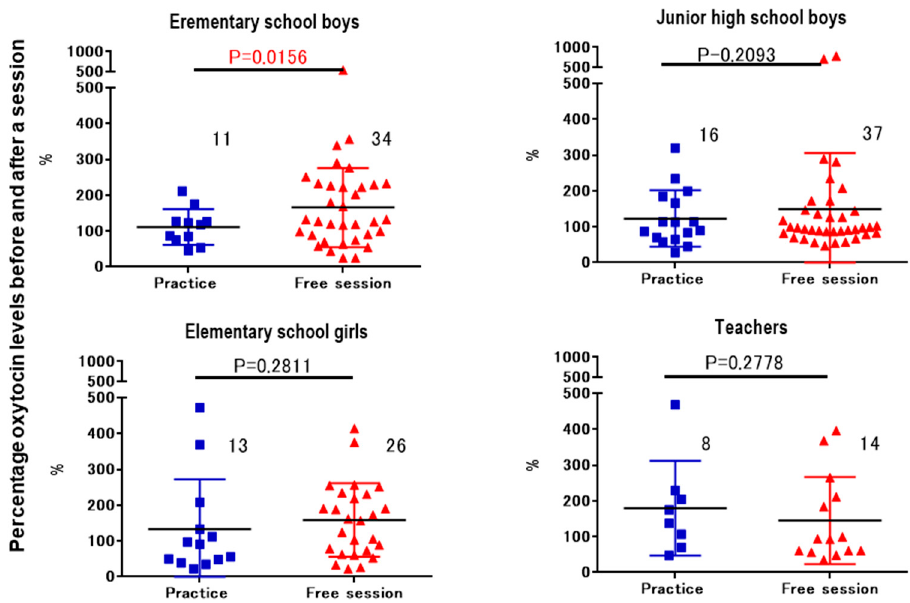
Figure 5. Changes in oxytocin levels before and after a single session. Percentage of oxytocin levels for the first (before) saliva over the second (after) saliva samples. Saliva was collected at practice and free play sessions from elementary school boys, junior high school boys, elementary school girls, and teachers. p values are for two-tailed Student’s t -tests.